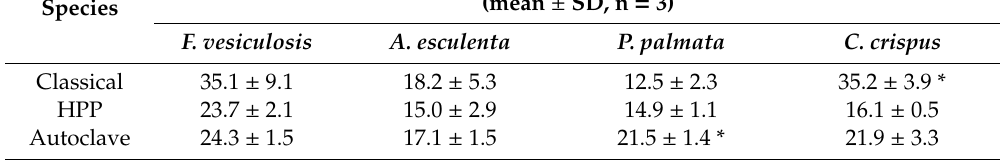
Table 1. The percentage of extractable protein obtained from di ff erent macroalgae treated using the classical protein extraction method, high pressure processing (HPP) or autoclave pre-treatment methods. Percentage of Extracted Protein Obtained Following Pre-Treatment Species